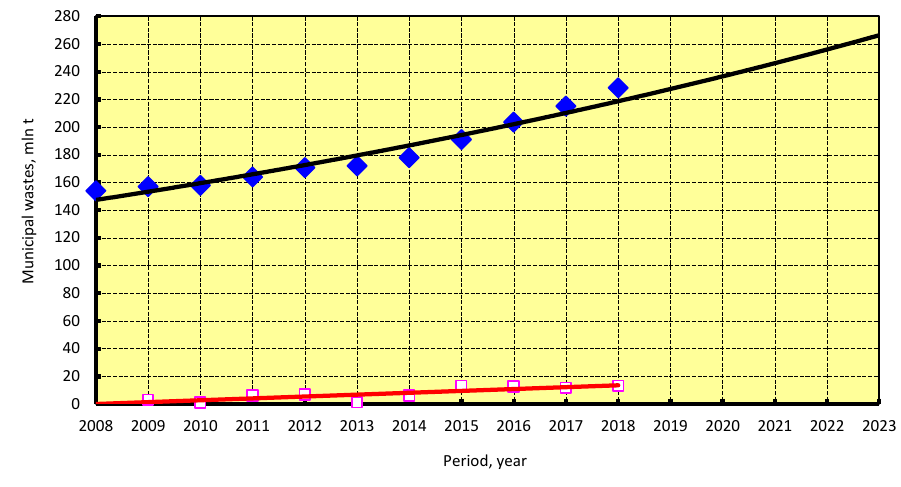
Figure 16. Municipal solid waste collected.